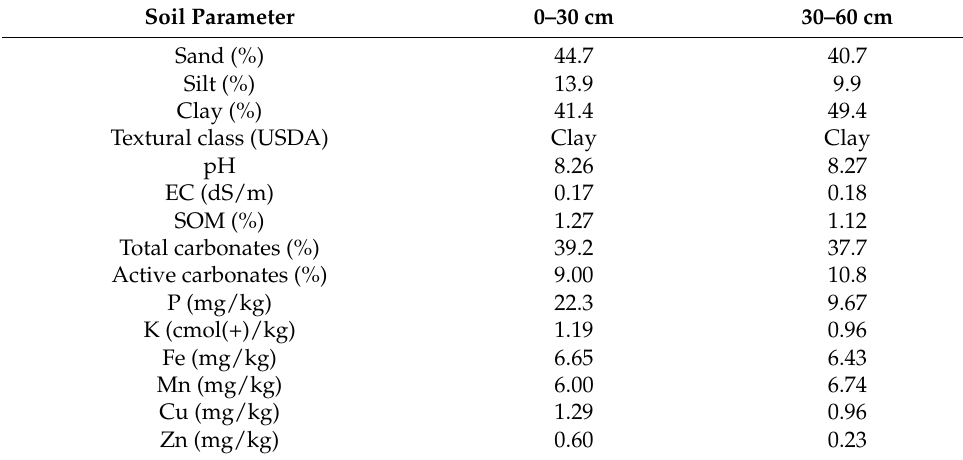
Table 10. Average soil characteristics before application of the treatments (n =